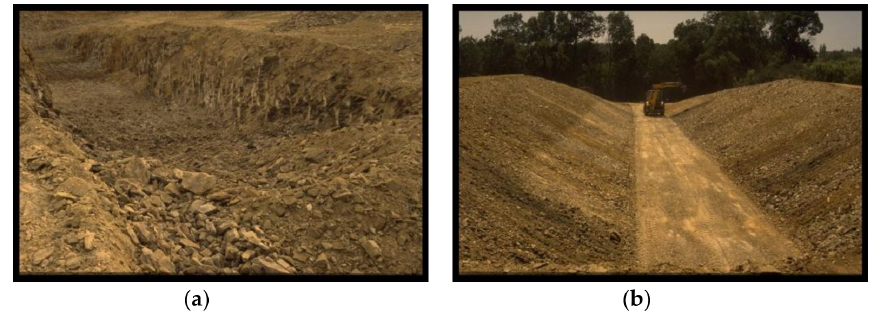
Figure 3. ( a ) Excavation of the mica schist ground support; ( b ) shape of the test site between